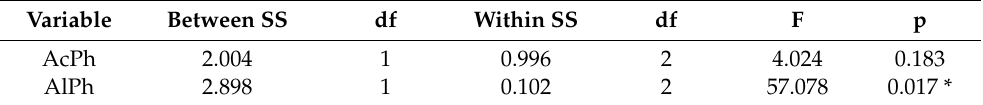
Table 9. Analysis of variance (k-means method) for AcPh and